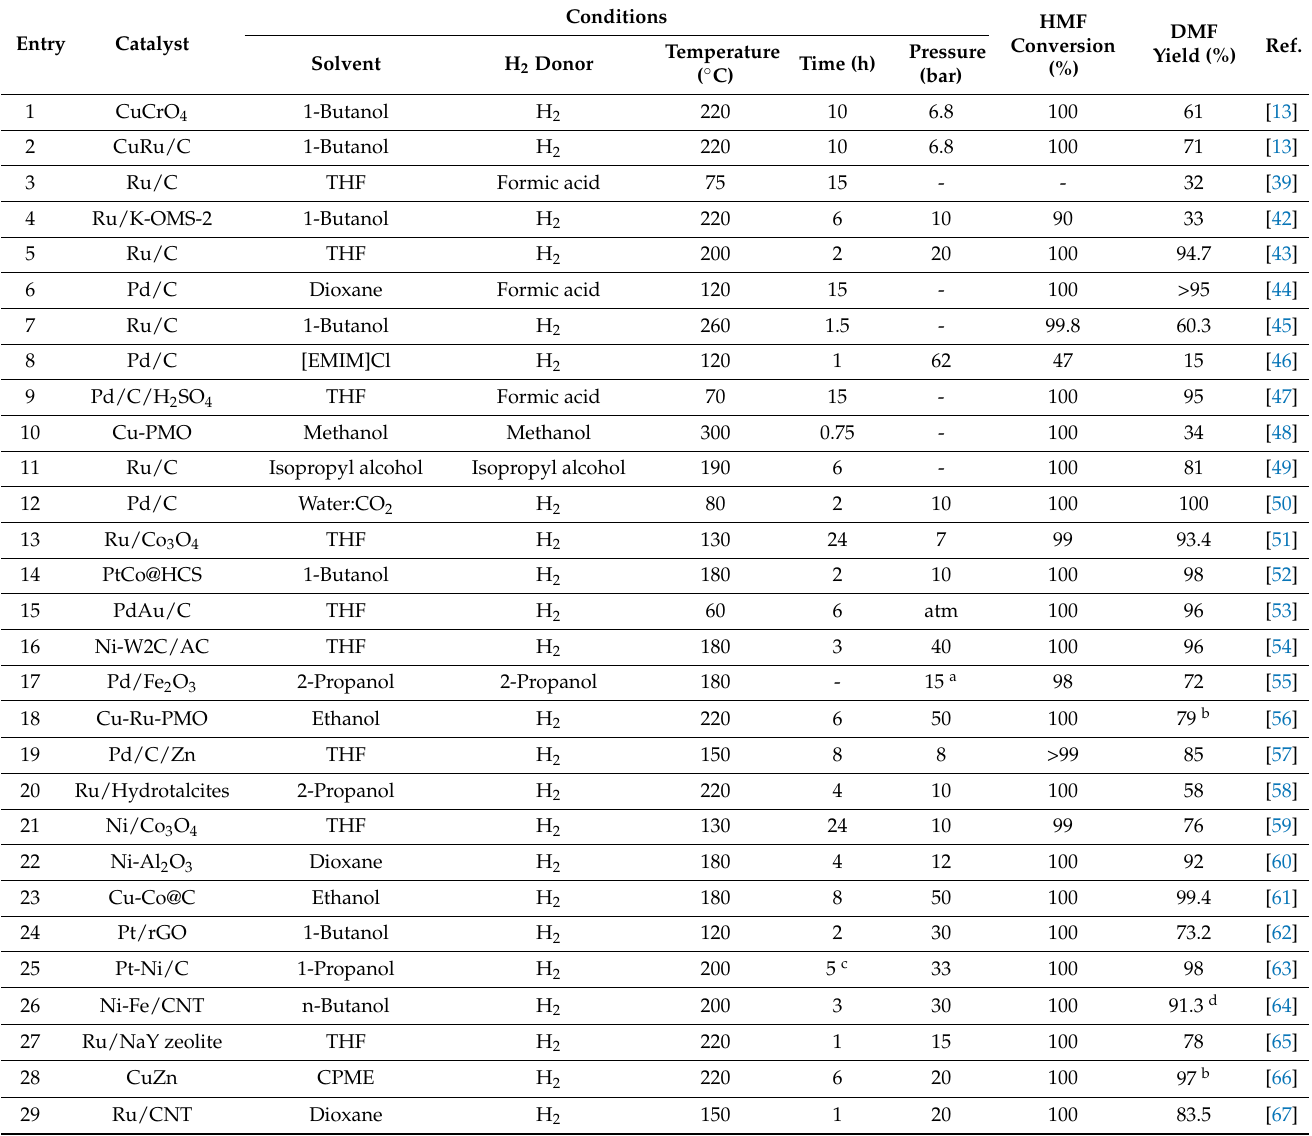
Table 2. Overview of DMF production from HMF in the